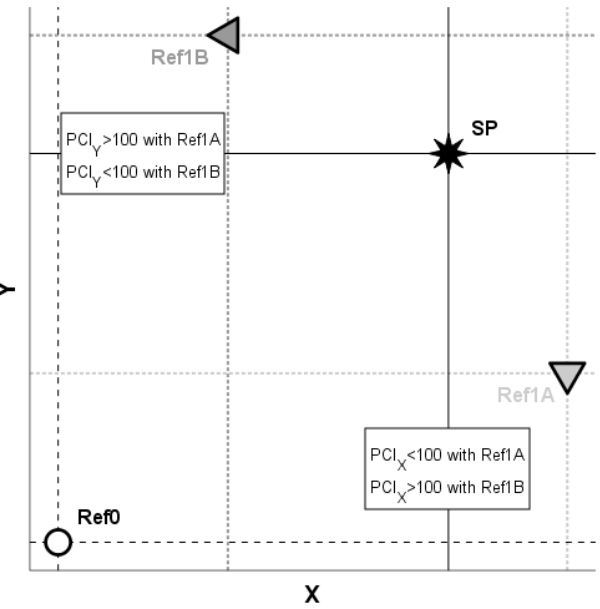
Figure 4. Schematic illustration of the dependence of the comparison of the PCIs of different varia- bles on the choice of the diseased reference population. If Ref1A is chosen as the diseased reference population, then PCI X < PCI Y . If Ref1B is chosen as the diseased reference population, then PCI X > PCI Y